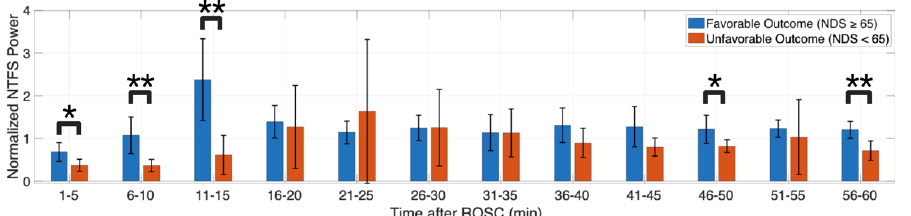
Figure 7. HFO NTFS power showed significant separation between favorable ( n = 6) and unfavorable ( n = 5) outcome groups during the first 60 min post-ROSC. * p < 0.05, ** p < 0.01. Created with Biorender.com.